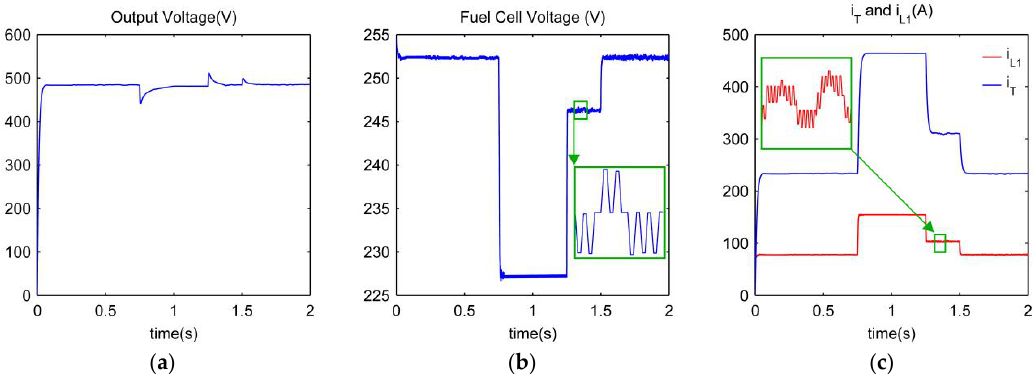
Figure 11. Responses of DC side of the hybrid micro grid ( a ) Output voltage; ( b ) Fuel cell voltage; ( c ) Phase current of boost converter and fuel cell current.